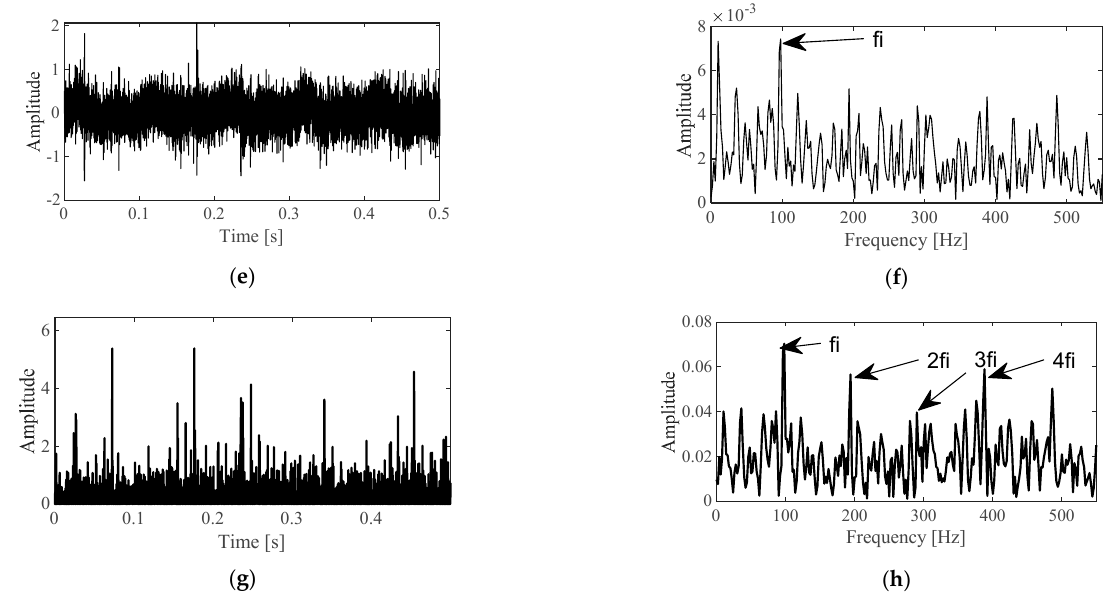
Figure 2. The filter result of the rolling bearing simulated signal based the proposed AMF. ( a ) Periodic impulses. ( b ) Harmonic components. ( c ) Random impulses. ( d ) White noise. ( e ) Mixed signal. ( f ) Envelope spectral of the signal shown in ( e ). ( g ) The filtered signal of the mixed signal shown in ( e ) using the proposed AMF. ( h ) Envelope spectral of the signal as shown ( g ).